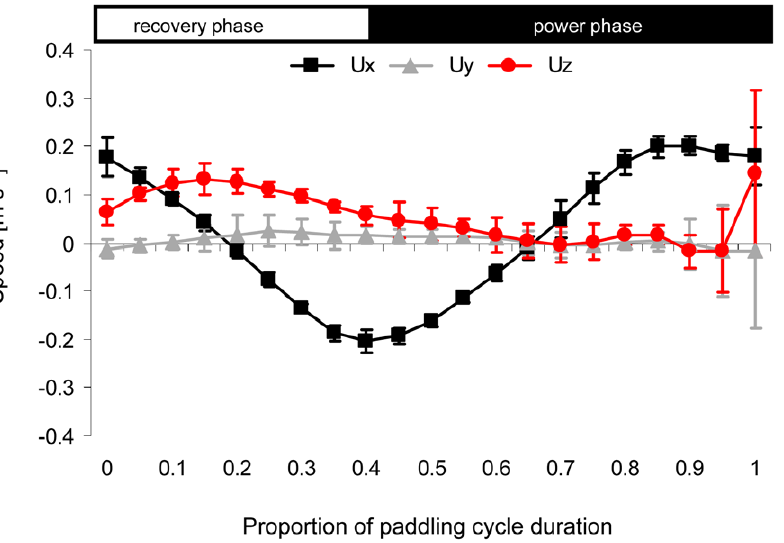
Figure 4. Velocity of the body in the duck frame of reference. The average velocity of the body shown as components along the three axes fixed on the duck. Ux, Uy and Uz are the component of velocity along the long, lateral and dorsoventral axes of the body respectively (see Fig. 2 and Appendix S2). The time (horizontal) axis is normalized time within a paddling cycle. The horizontal white and black rectangles at the top illustrate the division of the paddling cycle into the power and recovery phases. Data averaged from N=4 birds, 6 SD.